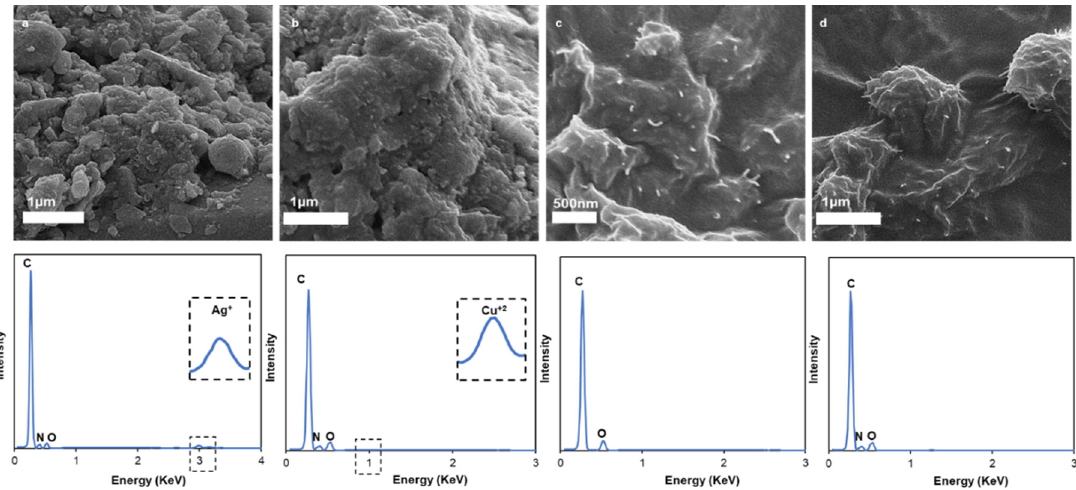
Figure 6. HRSEM images and EDX spectra of MWCNT/PANI/Ag + ( a ); MWCNT/PANI/Cu 2+ ( b ); MWCNTs ( c ); MWCNT/PANI conjugate ( d ).